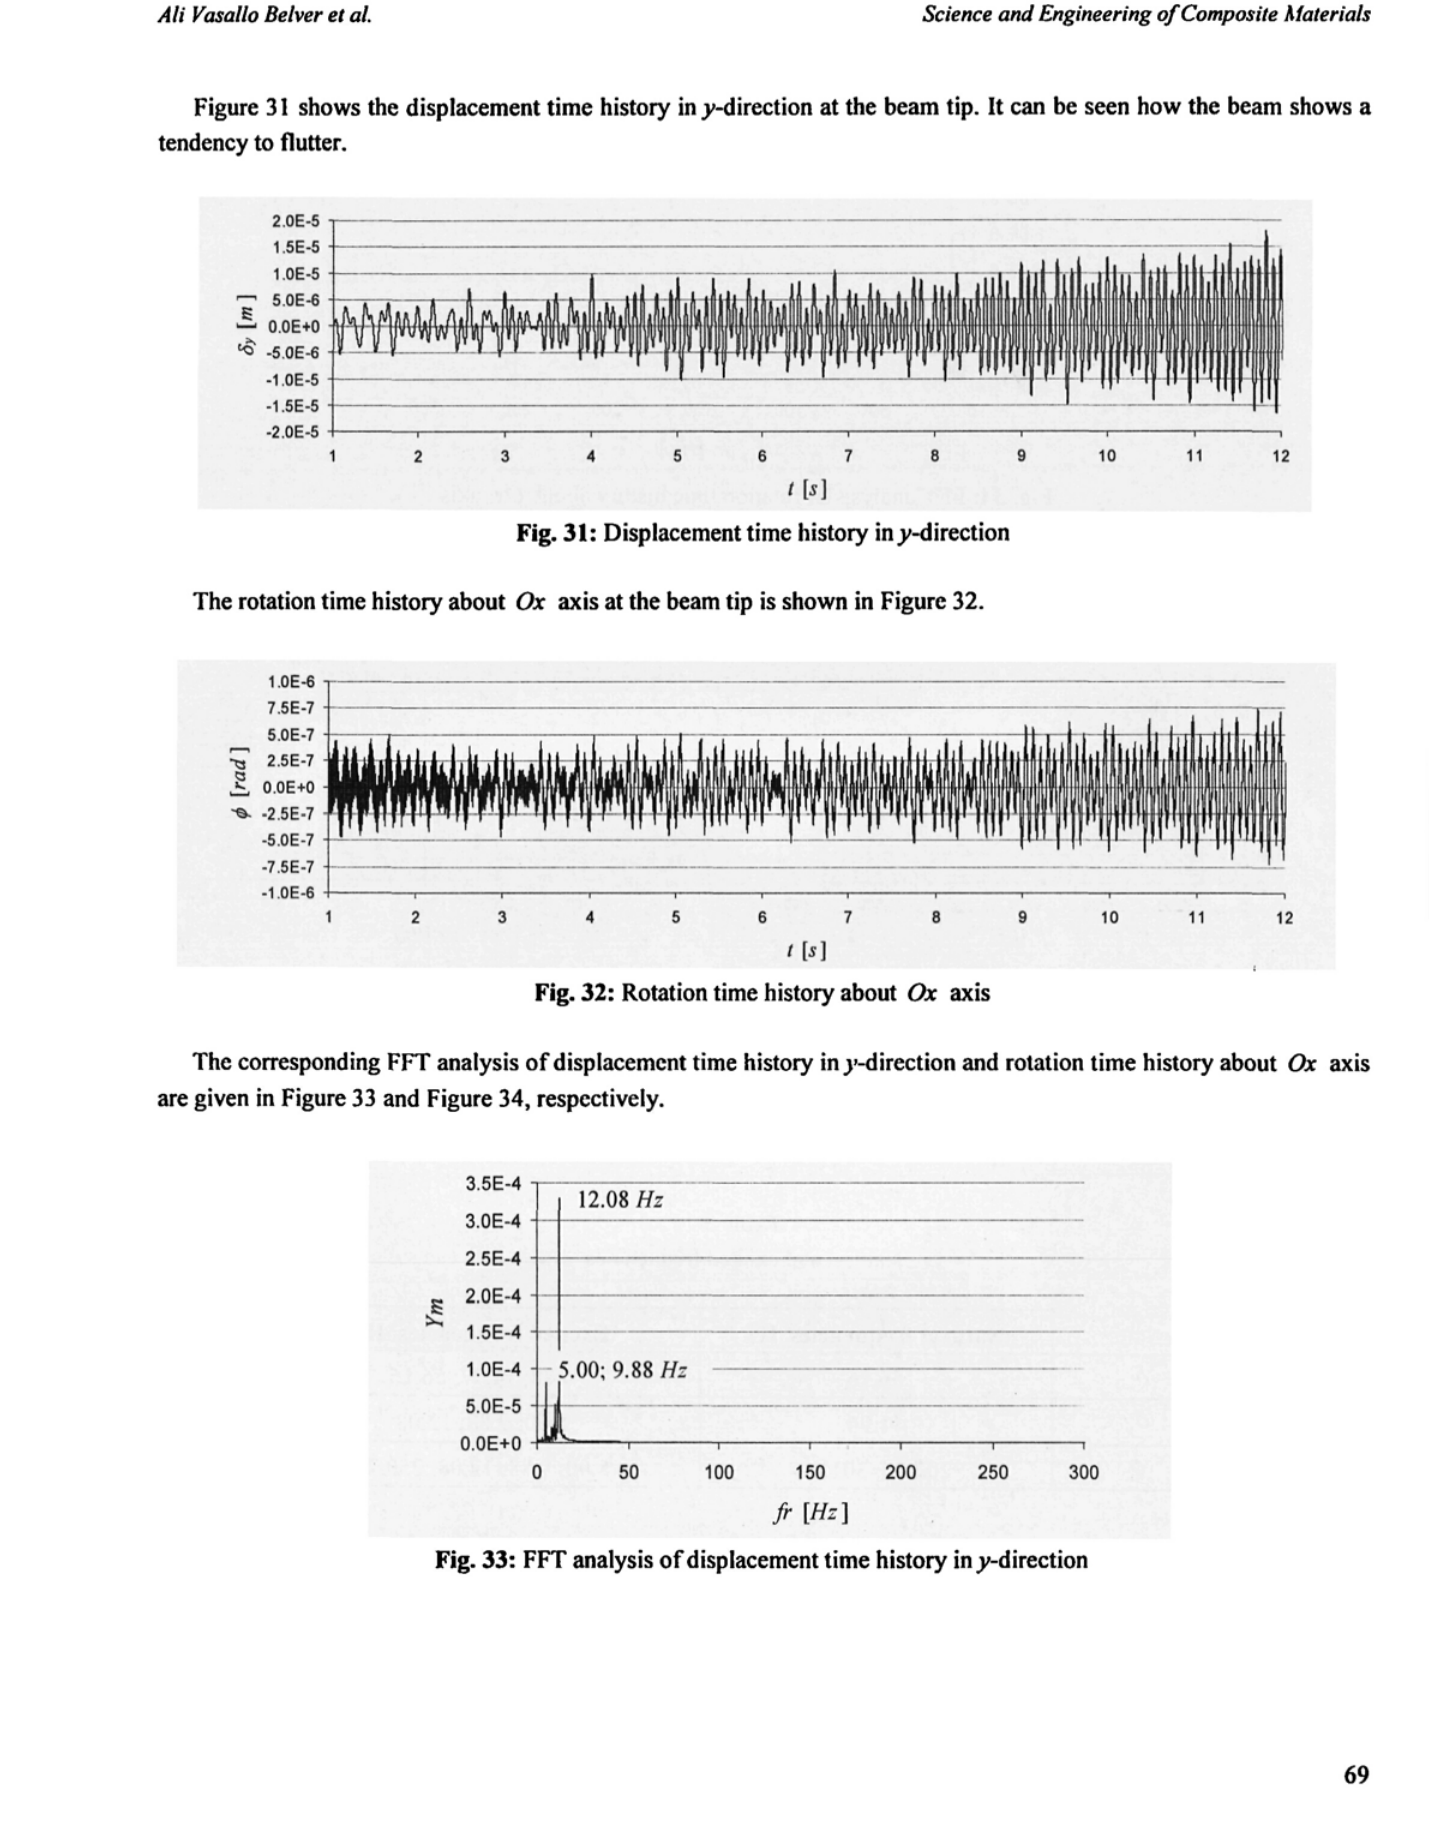
Fig. 33: FFT analysis of displacement time history